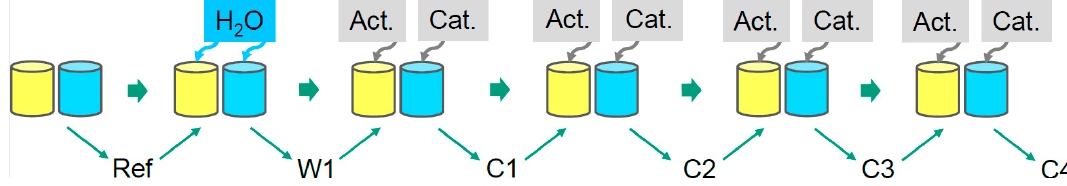
Figure 8. Order of water addition and compensation procedure.